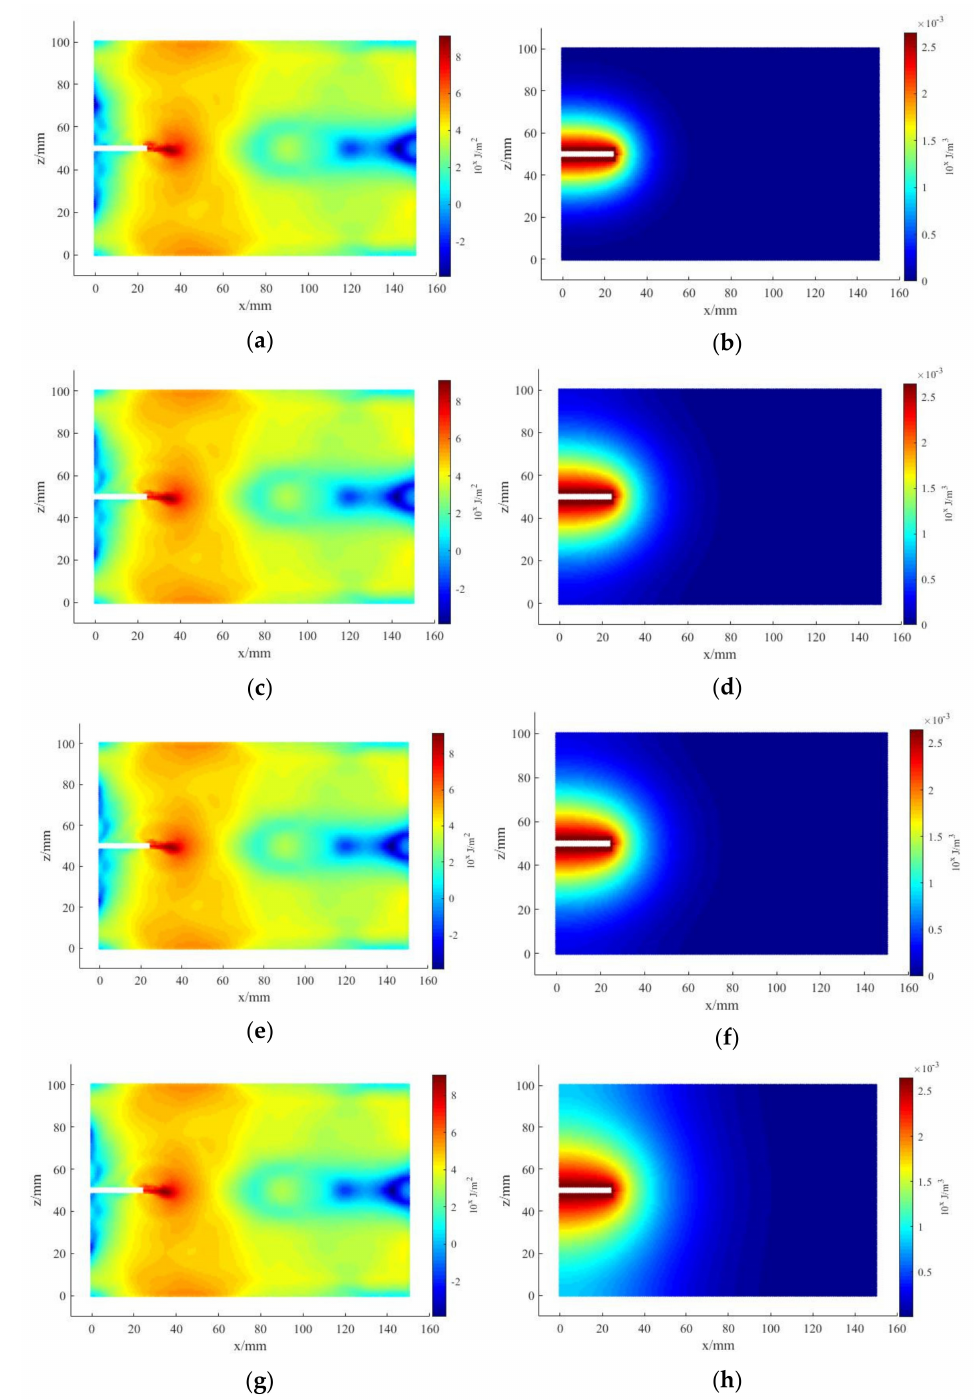
Figure 7. Energy diagram (( a ) T = 30 t , ( c ) T = 40 t , ( e ) T = 50 t , and ( g ) T = 60 t ) and corrosion diffusion field (( b ) T = 30 t , ( d ) T = 40 t , ( f ) T = 50 t , and ( h ) T = 60 t ) in the 500-time-step